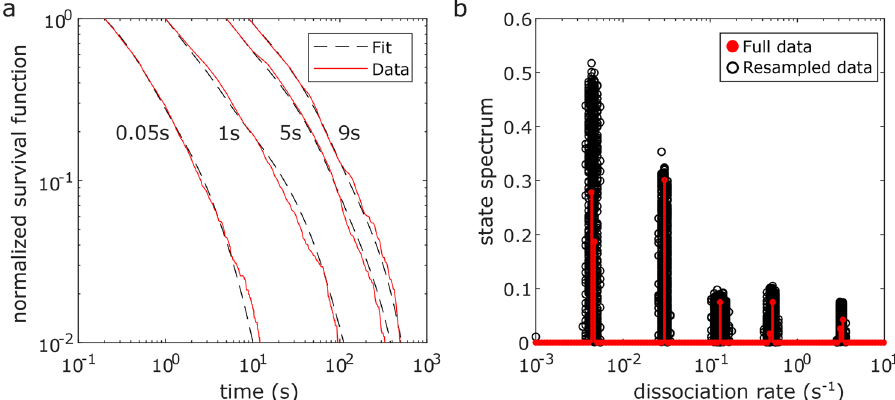
Figure 4. Re-analysis of CDX2 dissociation rate spectrum. Live-cell single molecule movies of SiR-Halo- CDX2 32 where analysed using the tracking radii suggested by theory for a tracking loss probability of 1e−2. ( a ) Fluorescence survival time distributions of tracked molecules (red lines) at different time-lapse conditions (indicated on top) and survival time functions obtained by GRID (black dashed lines). ( b ) State spectrum of SiR-Halo-CDX2 obtained by GRID using all data (red circles) and a superposition of 499 GRID results obtained by resampling 80% of data (black circles) as an error estimate of the state spectrum.